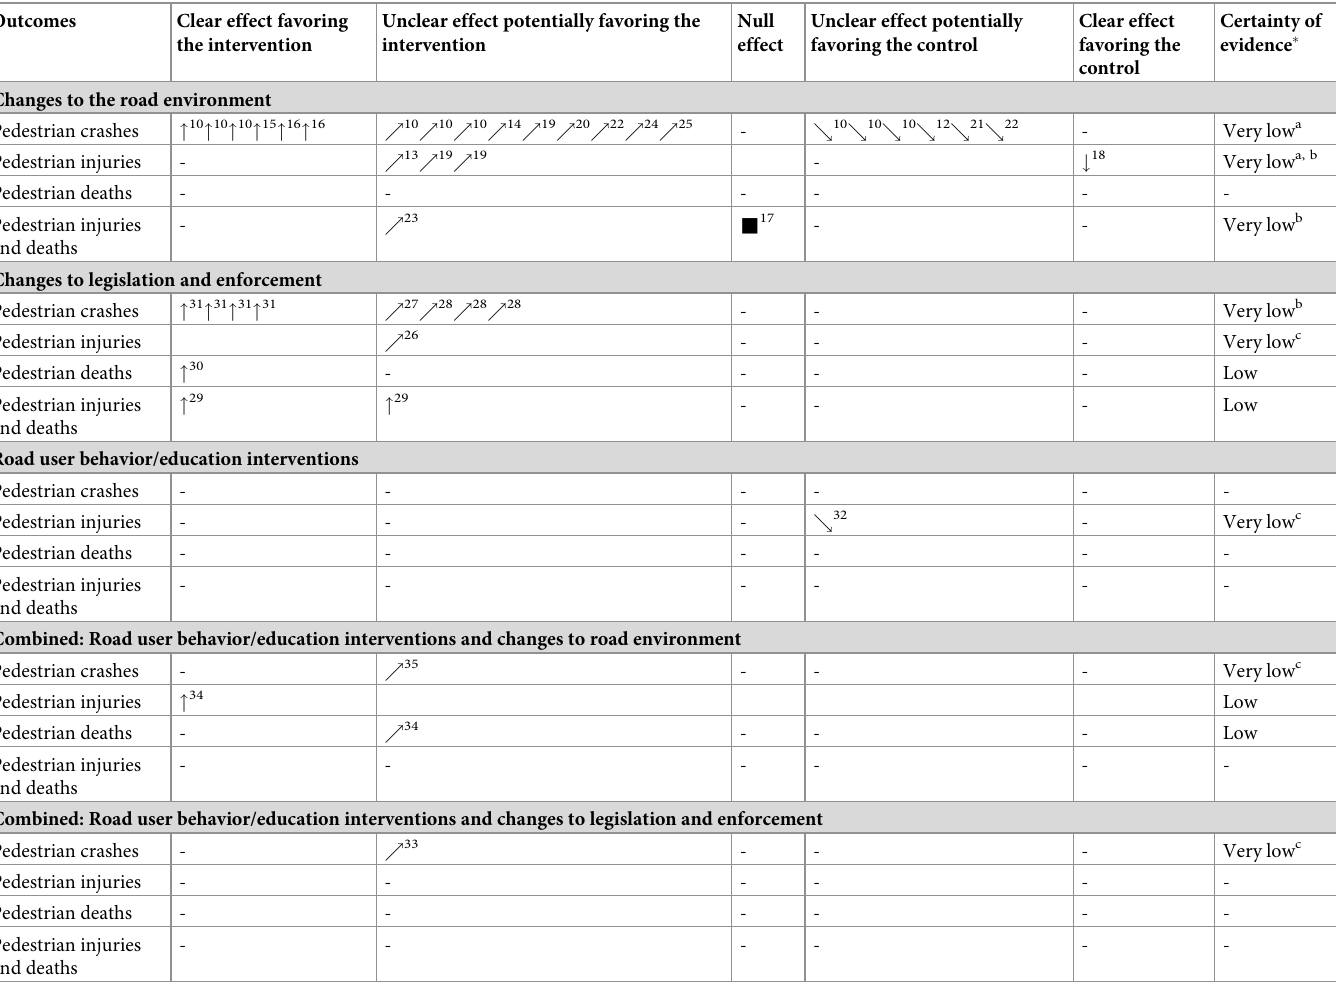
Table 3. Summary of effect directions, stratified by intervention category and